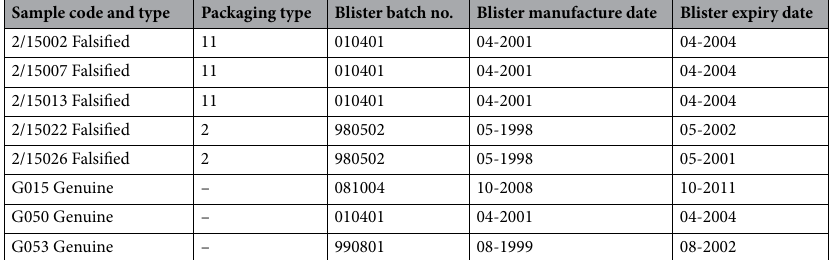
Sample code and